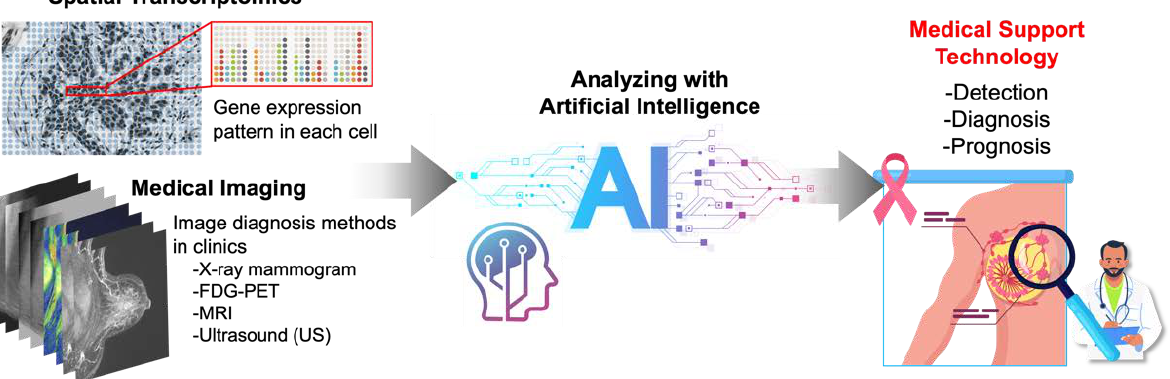
Figure 2. Artificial intelligence (AI) technology for spatial transcriptome data and medical image analysis, contributes to the development of medical support systems for practical applications.